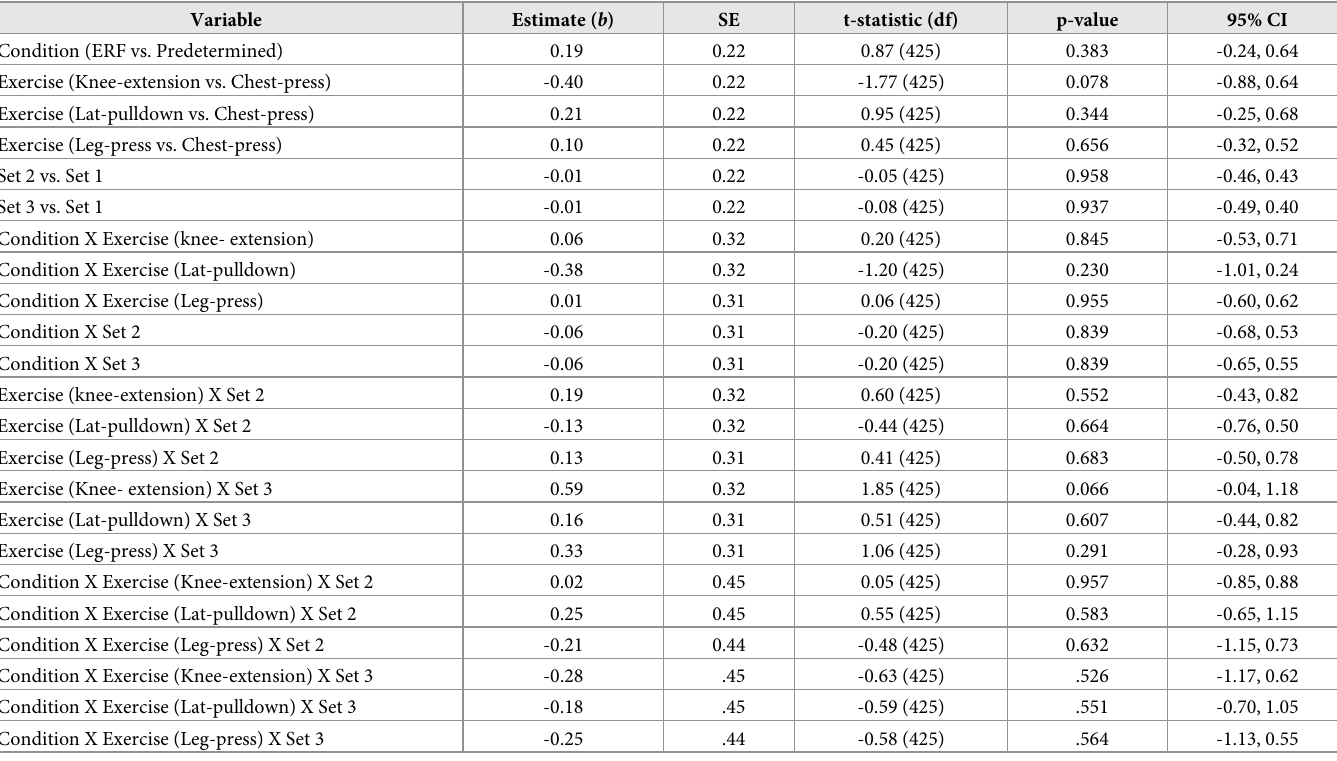
Table 2. Mixed model regression results.